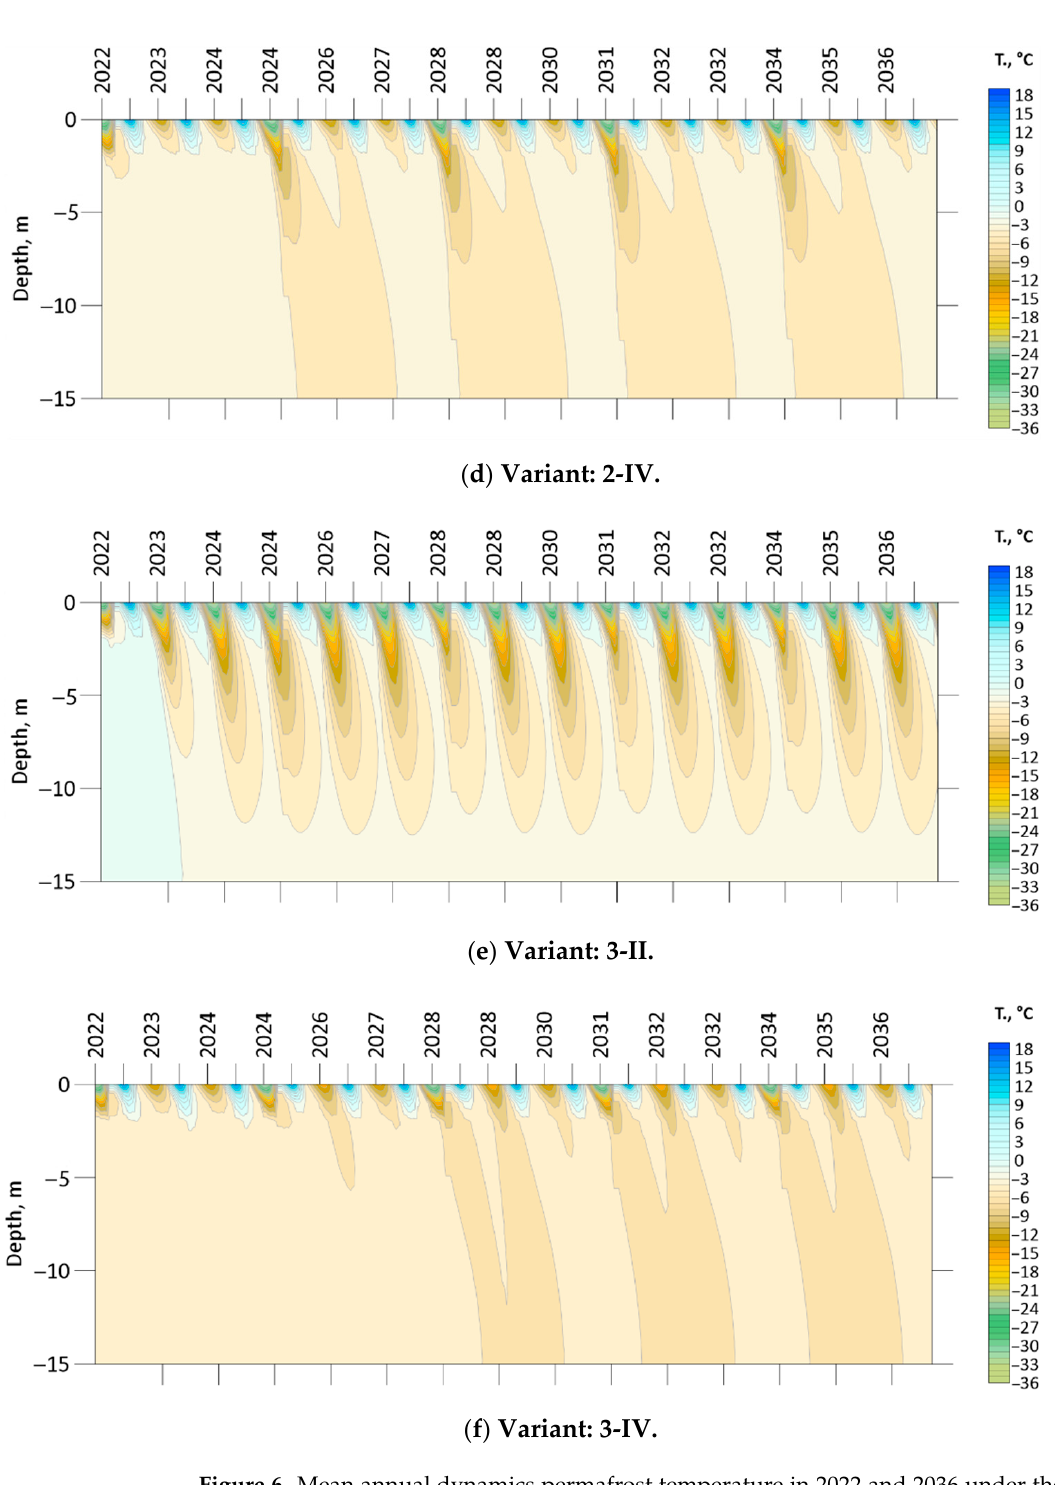
Table 8. : Optimal conditions for protective layer restoration.